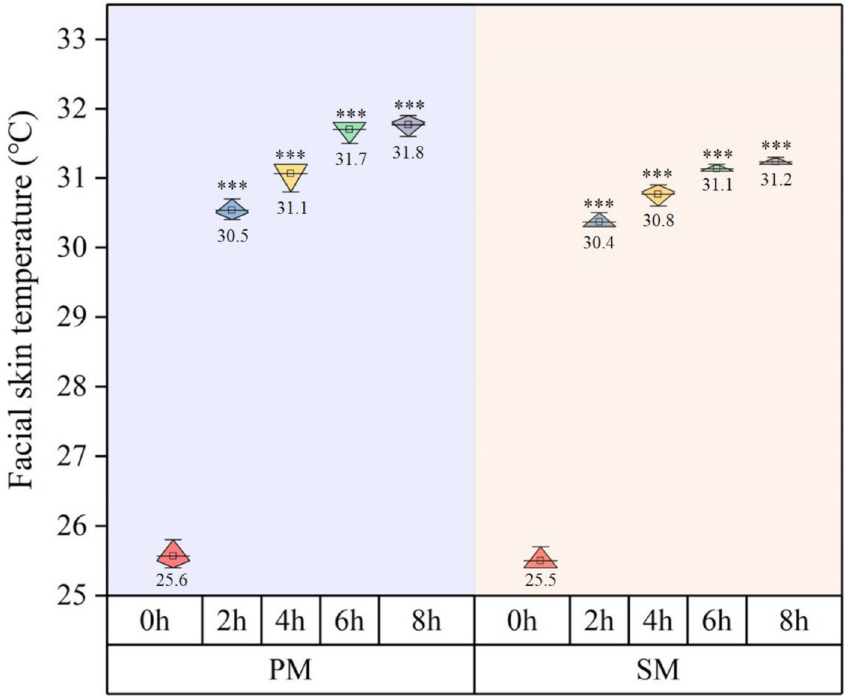
Figure 9. Results of experiments on facial skin temperature after removing masks. ***: p value < 0.001.